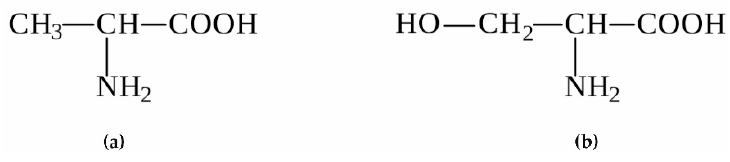
Figure 1. Structural formulae of alanine ( a ) and serine ( b ) molecules.